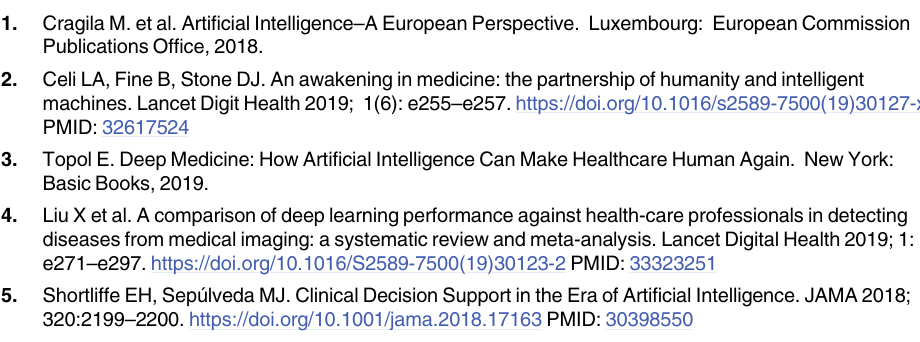
S1 Table. Artificial intelligence knowledge and perceived usefulness in medicine. S2 Table. Conflicts between judgement of physician and AI. S3 Table. Advantages of AI in medicine. S4 Table. Differences among groups regarding advantages of AI in medicine. S5 Table. Disadvantages of AI in medicine. S6 Table. Differences among groups regarding disadvantages of AI in medicine. S7 Table. Implementation